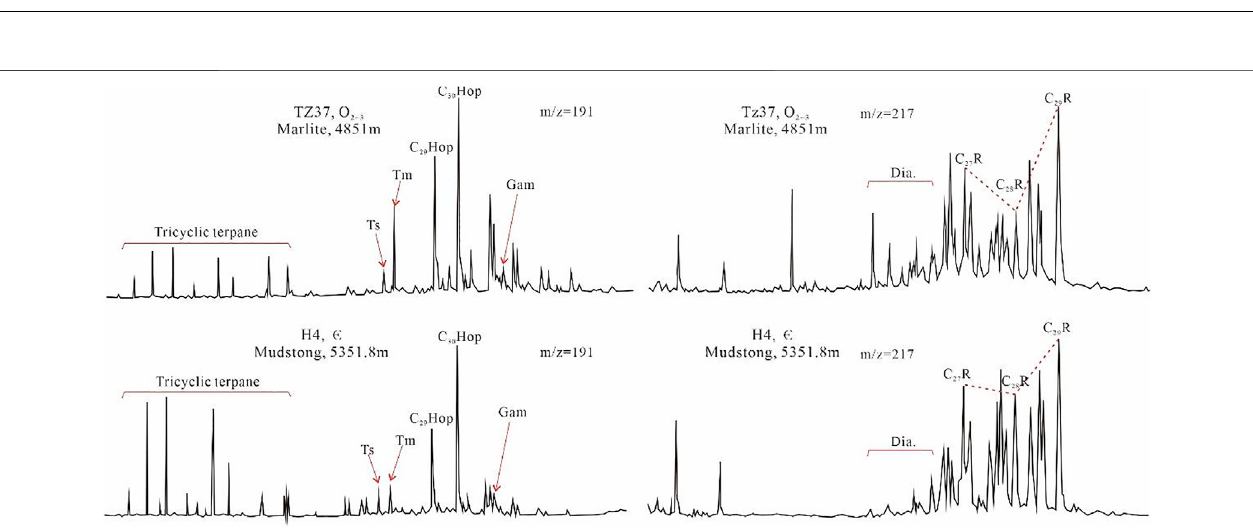
FIGURE 2 | Isotope distribution of kerogen in Cambrian-Ordovician source rocks in the Tarim Basin.